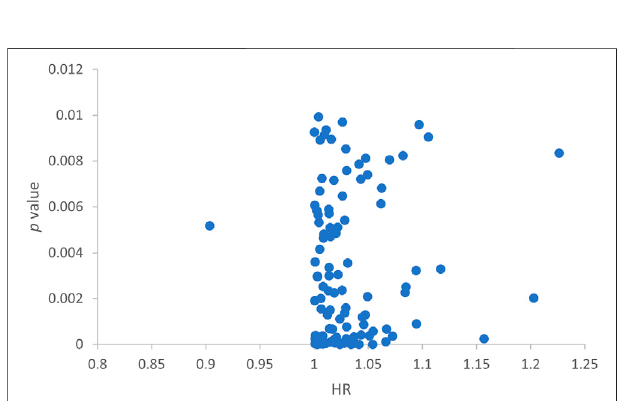
FIGURE 2 | Scatter plot showing lncRNAs screened by single-factor Cox